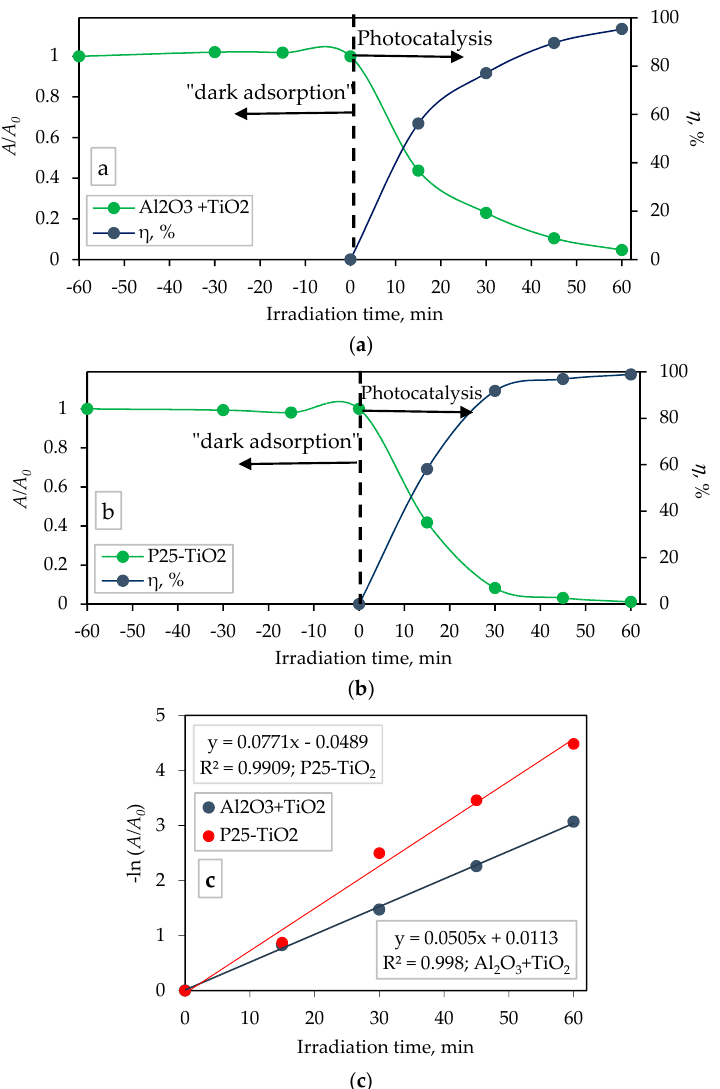
Figure 9. Adsorption and photocatalytic degradation of memantine as a function of irradiation time by: ( a ) TiO 2 -coated Al 2 O 3 foam, ( b ) suspended TiO 2 nanoparticles P25 and ( c ) first-order plot of